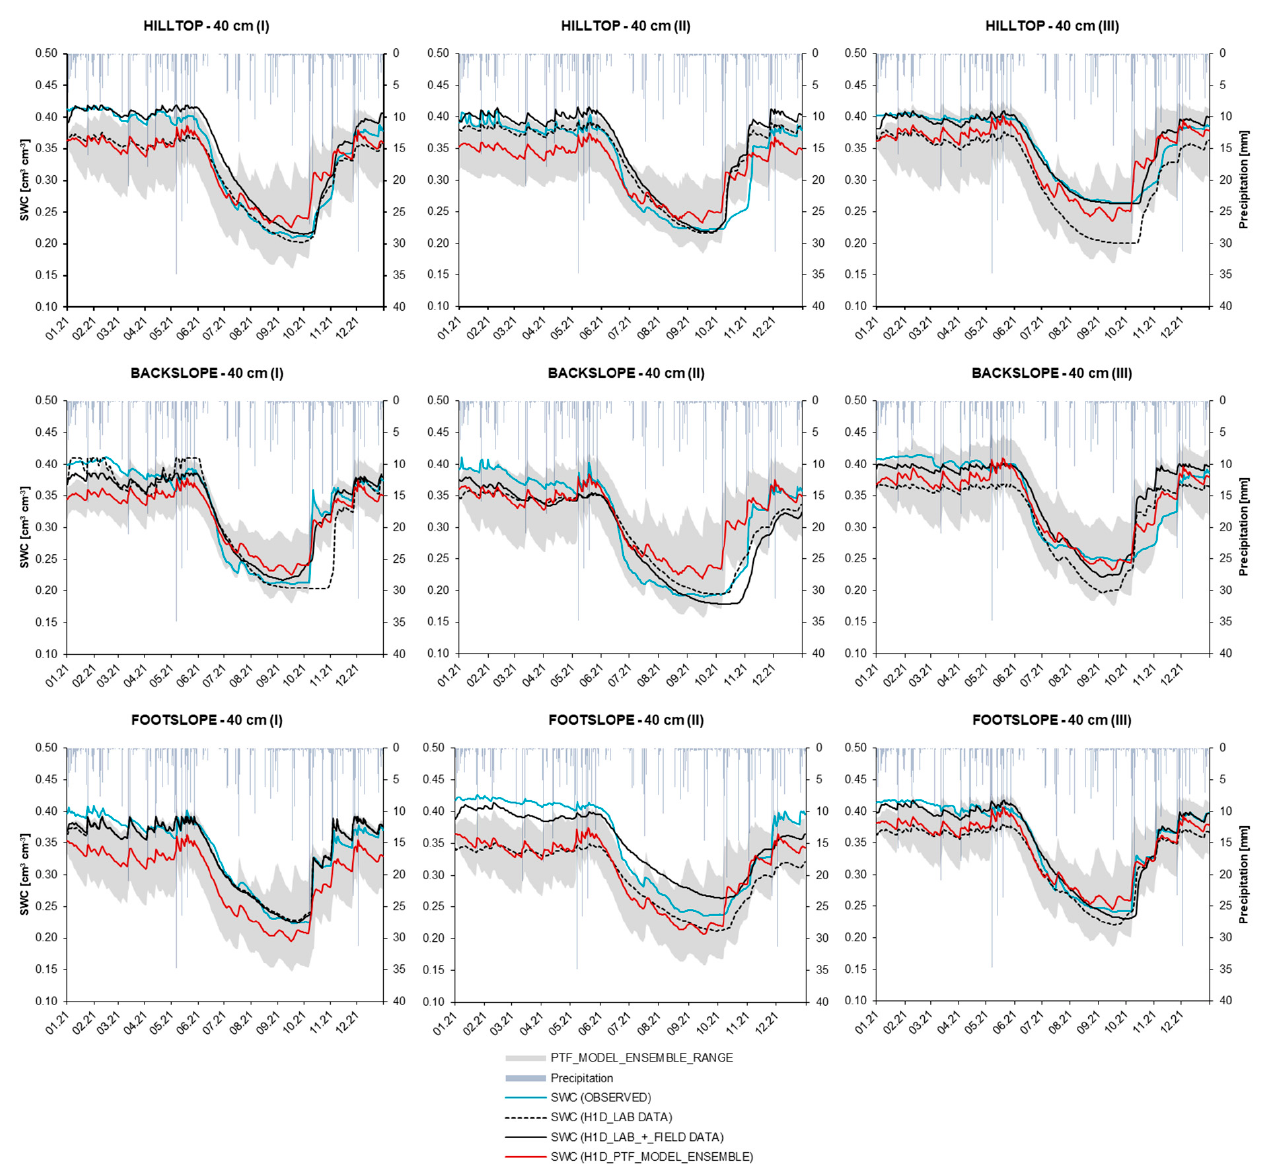
Figure 5. Simulated soil water content (SWC) [cm 3 cm − 3 ] in HYDRUS-1D: pedotransfer (PTF) model ensemble (red line), PTF model ensemble spread (5–95 percentile range) (grey area), laboratory dataset (dashed black line) and combination of lab and field data (black line), and field SWC measurements (blue line) in three vineyard rows at 40 cm depth, with precipitation data obtained with weighing lysimeter in 2021 at the SUPREHILL Critical Zone Observatory.